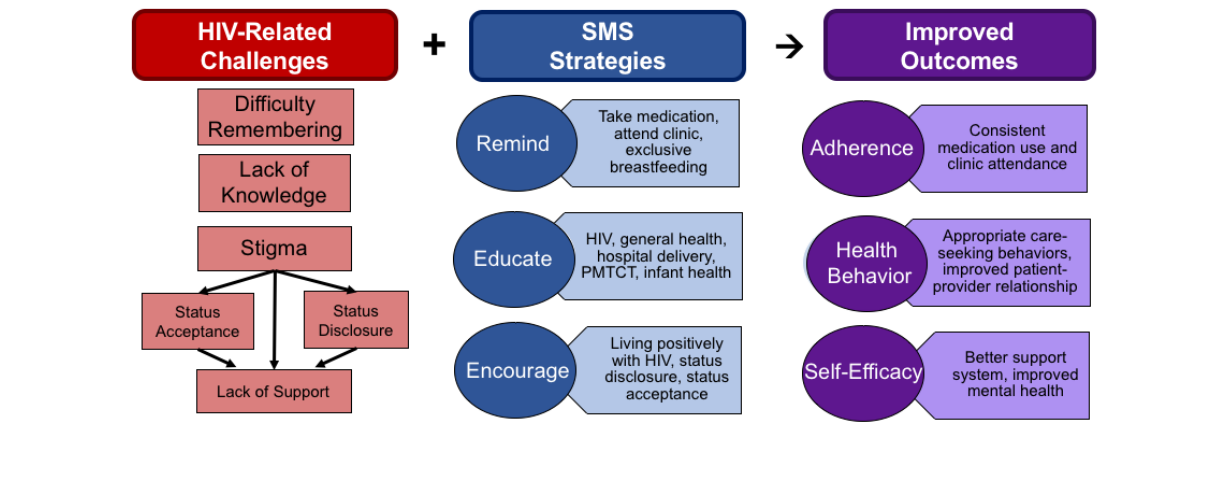
Figure 1. Summary of themes discussed in focus group discussions and interviews. PMTCT: prevention of mother-to-child HIV transmission. SMS: short message